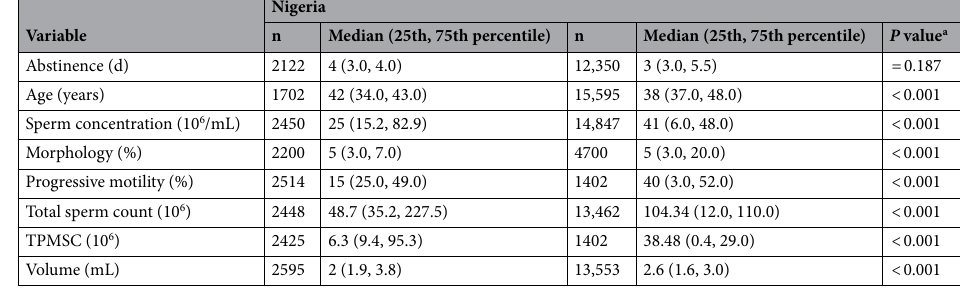
Table 1. Summary statistics of independent variable data from Nigeria and South Africa. a Mann-Whitney